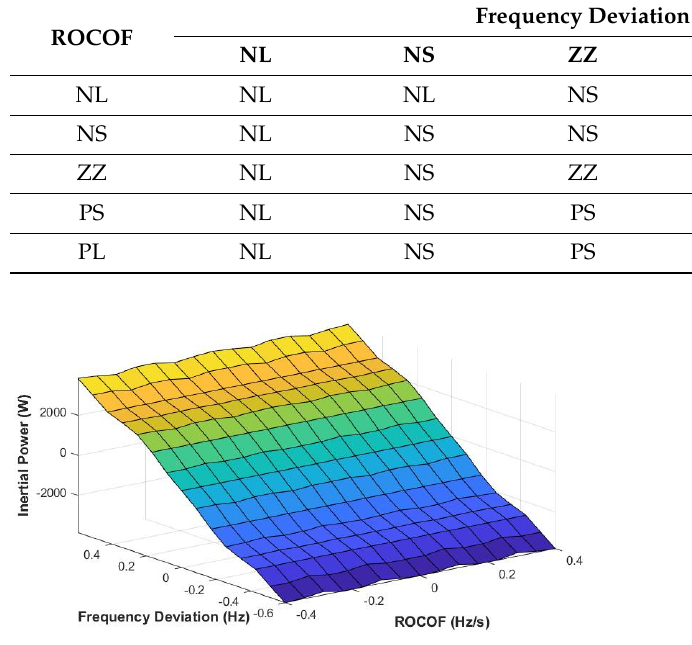
Figure 8. Surface plot of the fuzzy controller.